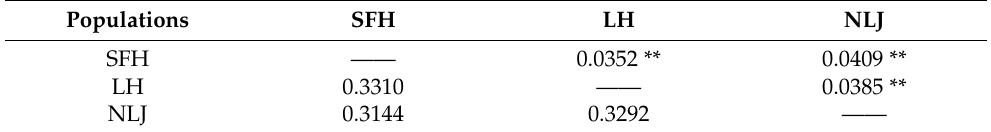
Table 3. Nei’s genetic distance ( D S , below the diagonal) and genetic differentiation coefficient (pairwise F ST values, above the diagonal) for Eriocheir s. s. populations. Populations SFH LH NLJ SFH —— 0.0352 ** 0.0409 ** —— 0.3310 0.0385 ** —— 0.3144